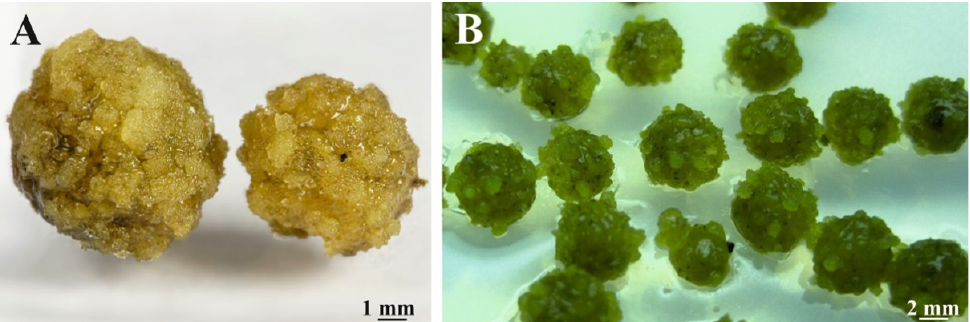
Figure 6. Rich cell proliferation of the cell suspension aggregates packed in the alginate capsules, after 4 weeks of the culture in MS medium supplemented with 2,4-D + BAP ( a ) and an application of encapsulated cell suspension for plant growth hormone tests ( b ). Insular tissue proliferation noted but lacking any evidence of the organ differentiation (5×).